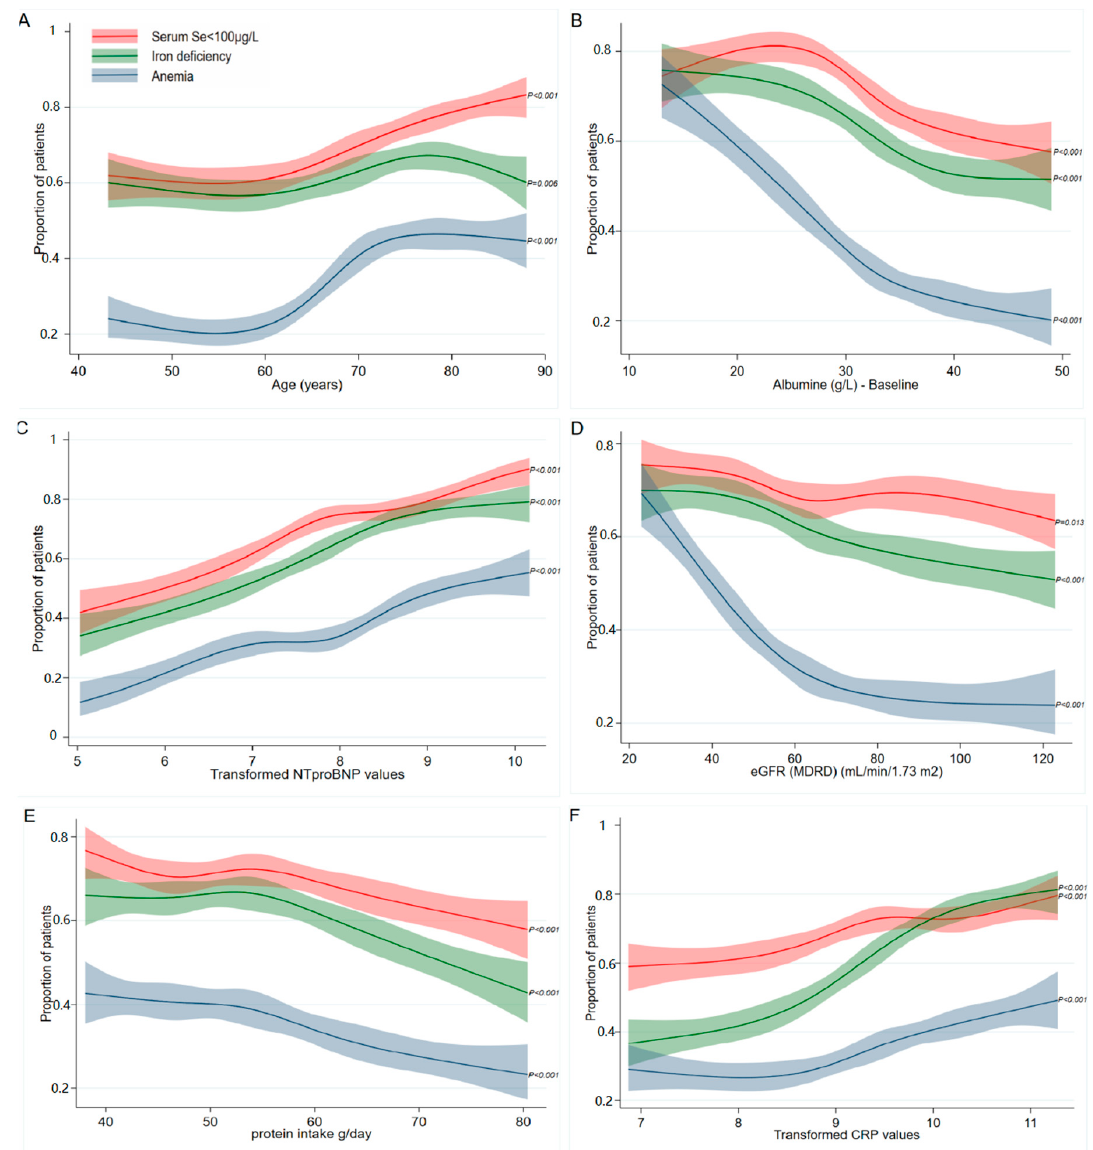
Figure 2. Comparing the prevalence of low serum Se concentrations, ID, and anemia. Restricted cubic splines of the association between the prevalence of serum selenium <100 µg/L, iron deficiency, and anemia and ( A ) age, ( B ) albumin levels, ( C ) transformed NT-proBNP values, ( D ) kidney function (according to the MDRD formula), ( E ) estimated protein intake, and ( F ) transformed CRP values. The solid lines indicate estimates of the prevalence of low selenium concentrations (red), ID (green), and anemia (blue) across continuous levels of the identified clinical determinants of low selenium, fitted using a logistic regression analysis. The shaded areas indicate 95% confidence intervals. The p -values indicate the significance of the whole cubic spline model for each factor.